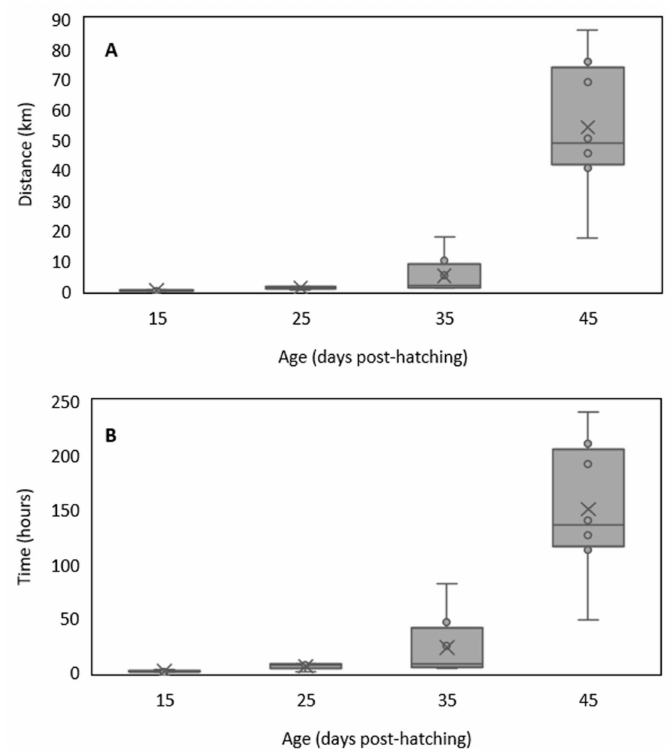
Figure 4. Distance (km) ( A ) and time (hours) ( B ) swam by white seabream Diplodus sargus (Linnaeus, 1758) larvae during swimming endurance experiments at 15, 25, 35, and 45 days post-hatching. The lines inside the boxes represent the median, × represents the mean, the lower and upper box limits represent the 25 th and the 75 th percentiles, whiskers represent the standard deviation, while dots represent the